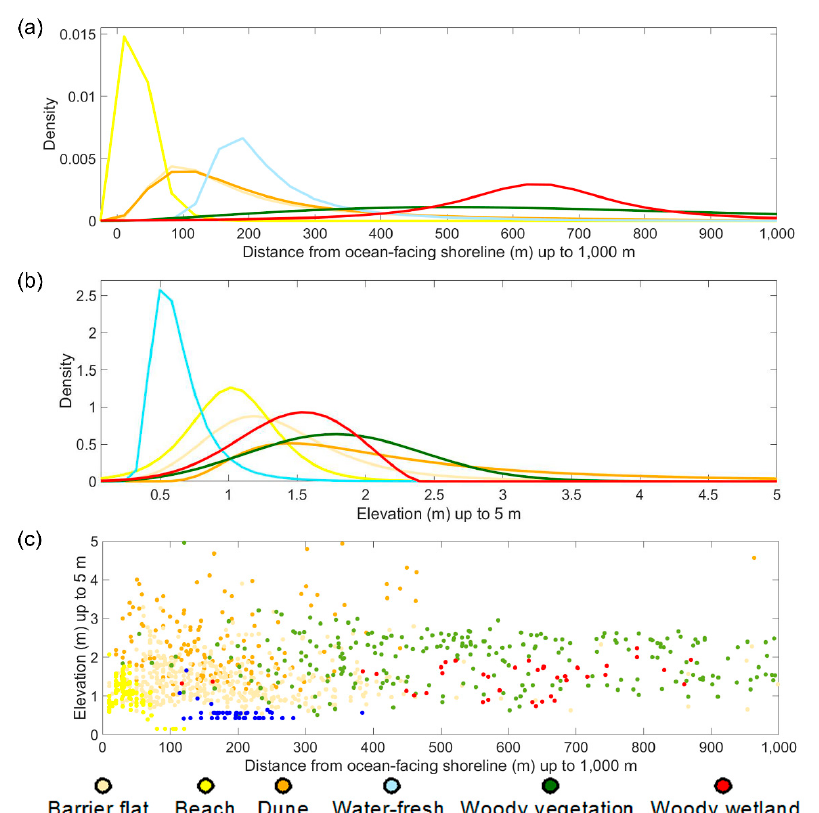
Figure 6. Probability density functions developed from the training data for the supratidal/upland zone from the contemporary (i.e., 2015) habitat model for Dauphin Island, Alabama, USA. ( a ) Distance (m) from the ocean-facing shoreline up to 1000 m; ( b ) Elevation (m) up to 5 m; and ( c ) a bivariate plot for these two variables.